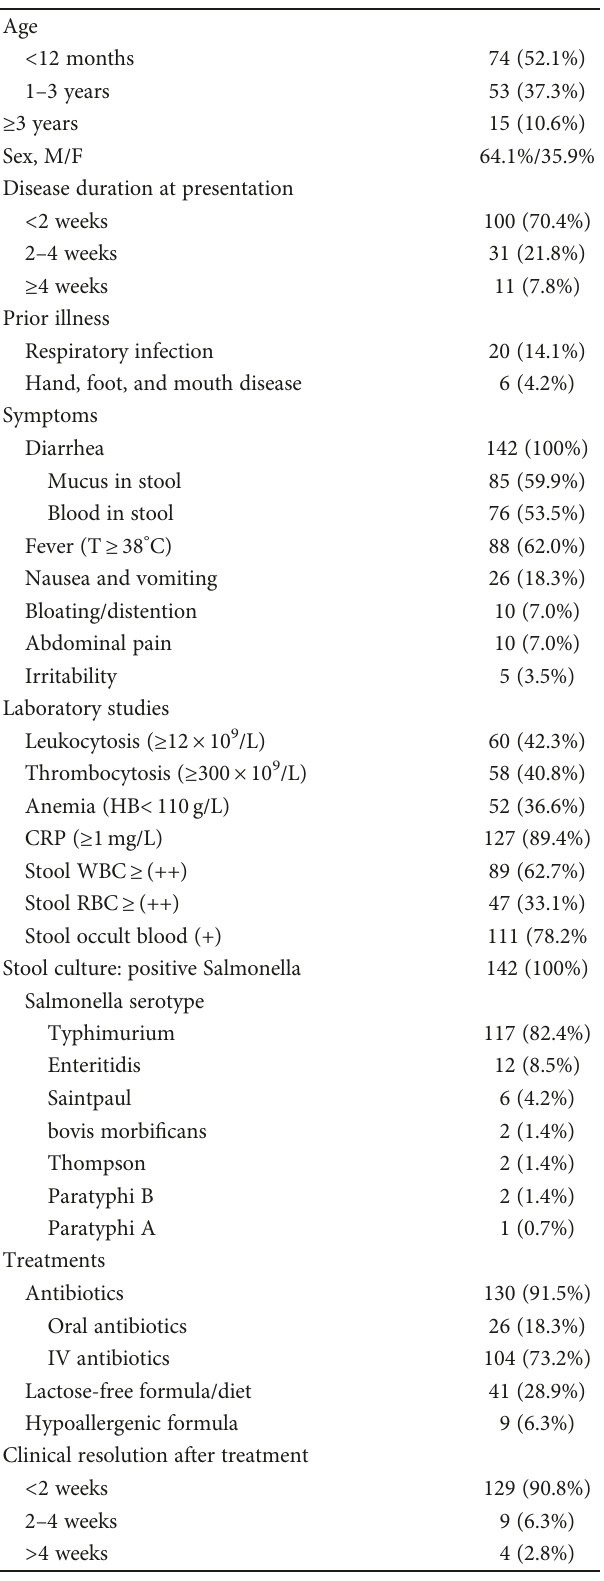
Table 1: Basic characteristics, clinical features, and laboratory tests and treatments in 142 infants and children with nontyphoidal Salmonella